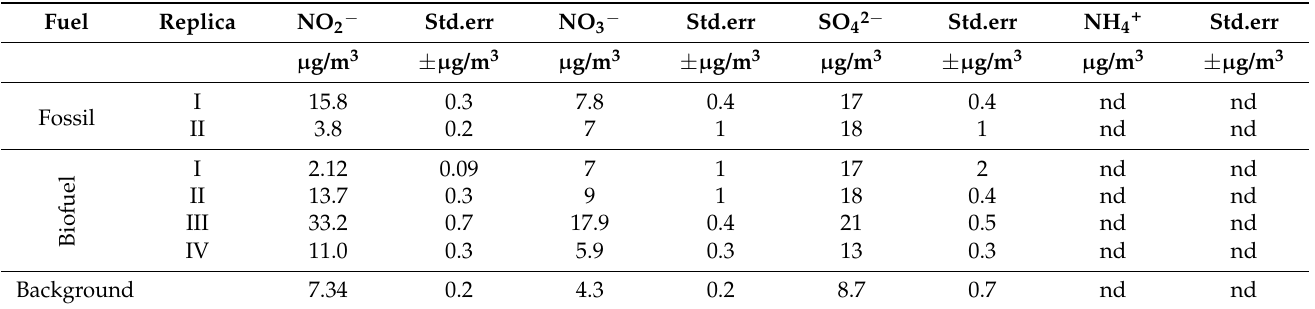
Table 6. Ionic species concentration in the QBQ filters. Data are reported as average (n > 2) and standard error. Concentrations below the detection limit of the technique are reported in the table as nd (not